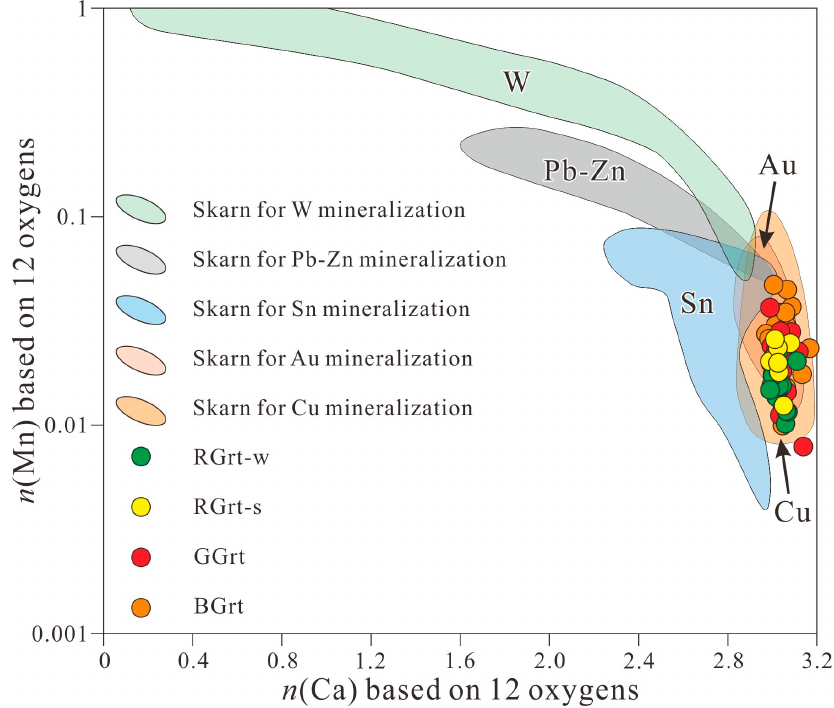
Figure 15. Discrimination diagrams of the mineralization properties for garnets in the Yongping Cu deposit (after [91]). The calculations for n (Mn) and n (Ca) are based on 12 oxygens. Abbreviations: RGrt-s = zone with stronger color intensity under BSE of dark red garnet; RGrt-w = zone with weaker color intensity under BSE of dark red garnet; GGrt = green garnet; and BGrt = light brown garnet.